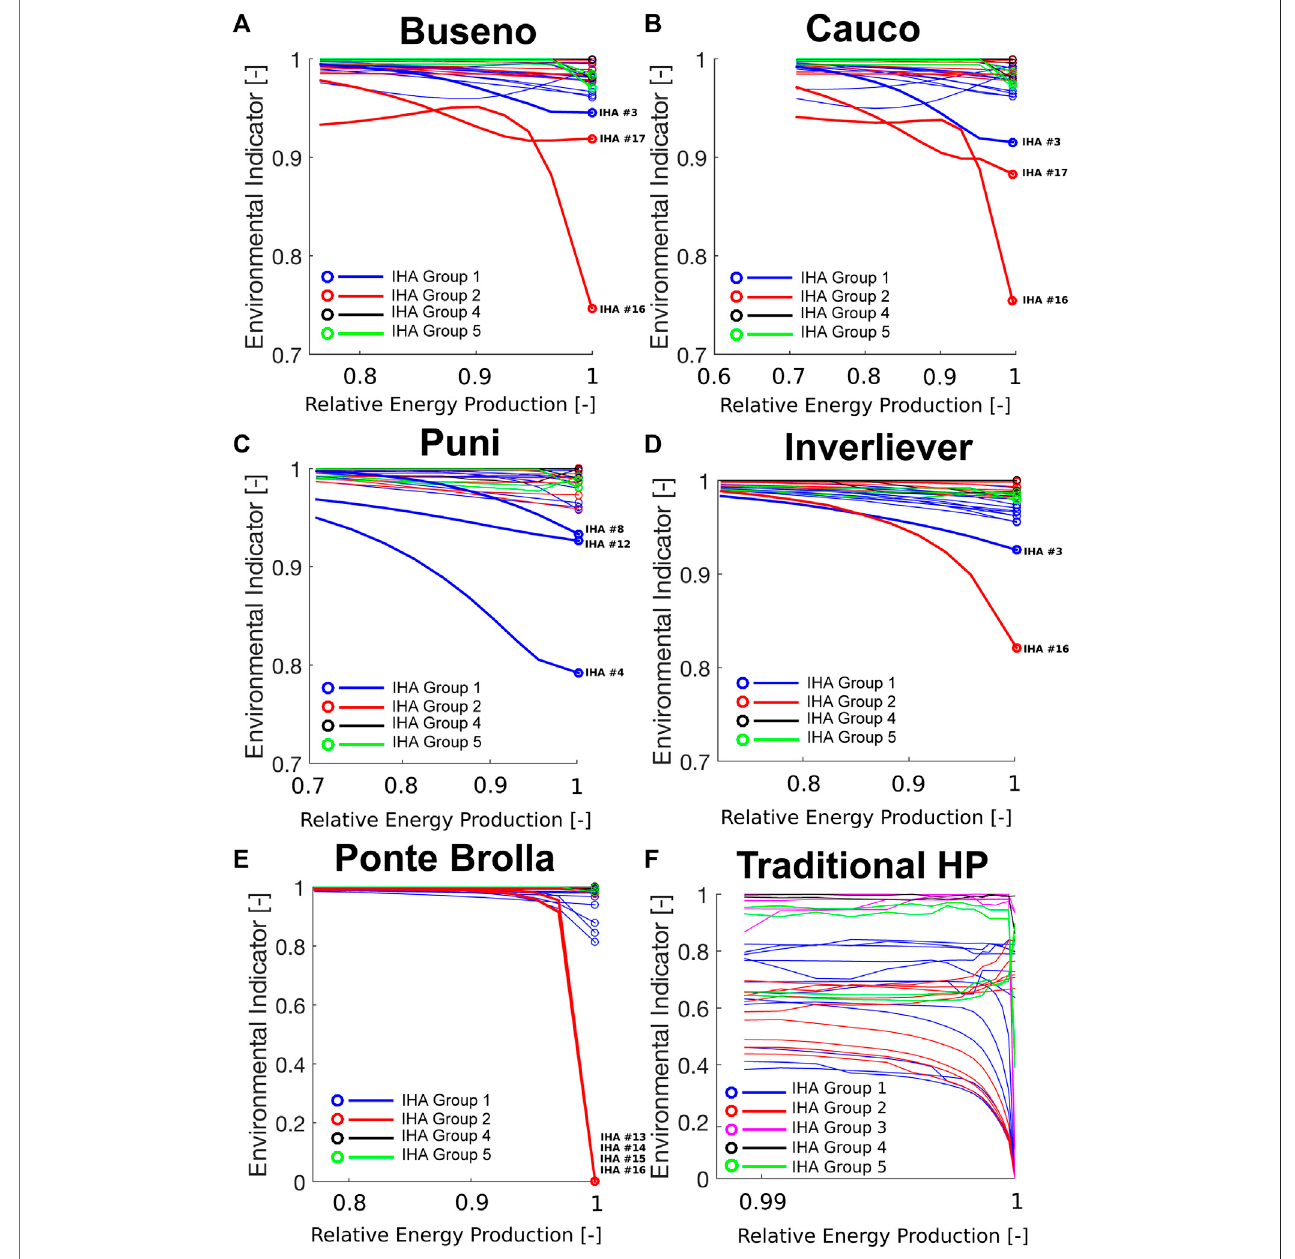
FIGURE 6 | Pareto frontiers resulting from improving proportional policies for each of the 32 IHA sub-indicators. Dots represent Q mfr policies. Each color refers to one of the fi ve groups of hydrological sub-indicators described in Table 1 . Plots (A) , (B) , (C) , (D) and (E) show the results for fi ve different SHP and (F) for a traditional Hydropower Plant. Broad curve lines represent the IHAs with the highest variability for each case